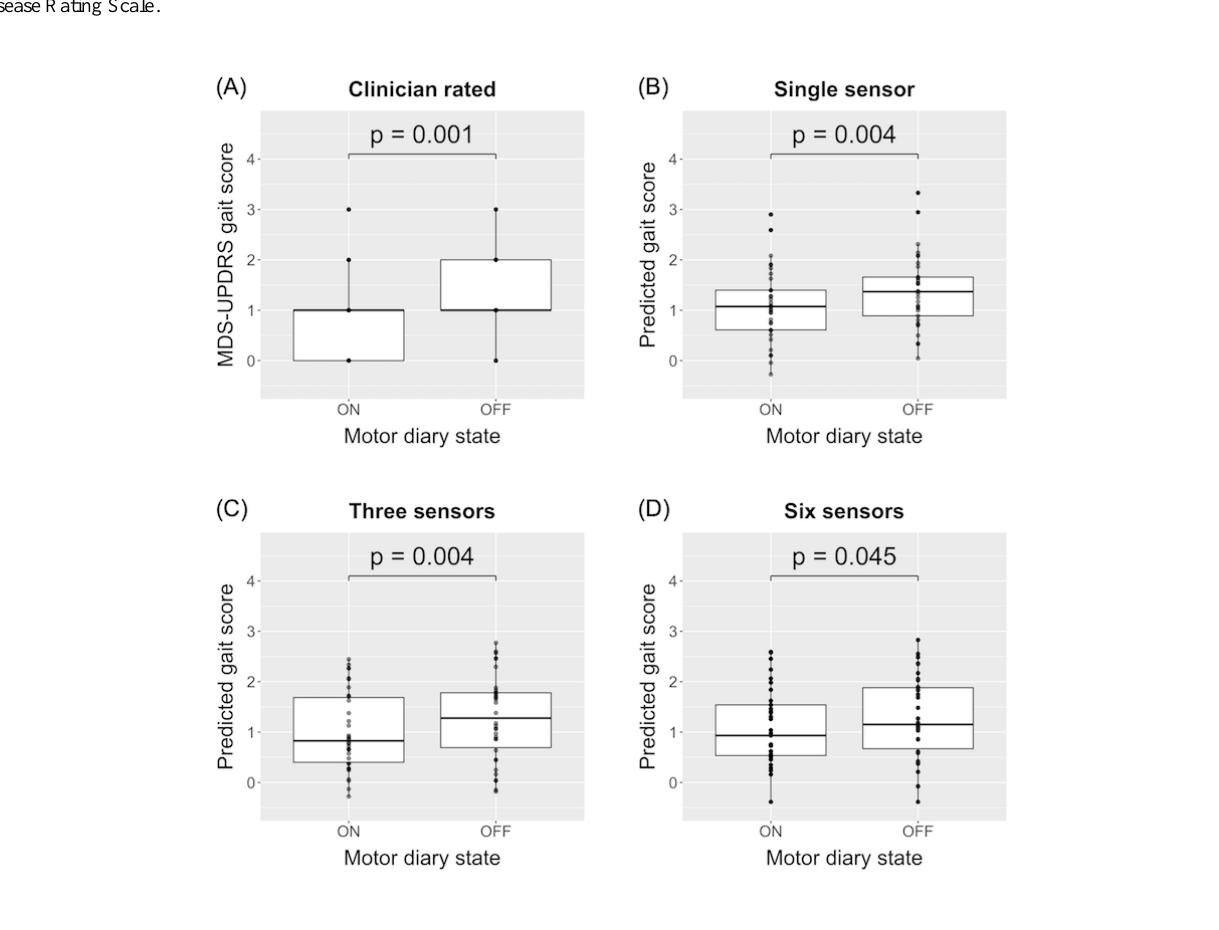
Figure 3. Distribution of the (A) clinician-rated gait score, (B) single device predicted gait score, (C) 3-device predicted gait score, and (D) 6-device predicted gait score, grouped by patient-reported On and Off motor states. MDS-UPDRS: Movement Disorder Society version of the Unified Parkinson Disease Rating